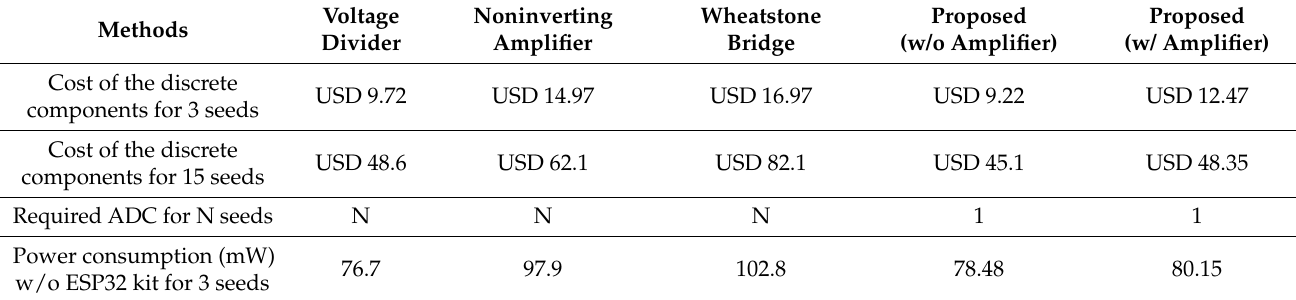
Figure 11. Conventional methods to measure the resistance of three FSRs: ( a ) The voltage divider method; ( b ) The noninverting amplifier method; ( c ) The Wheatstone bridge method. Table 1. A comparison between the proposed circuit design and other conventional circuits.